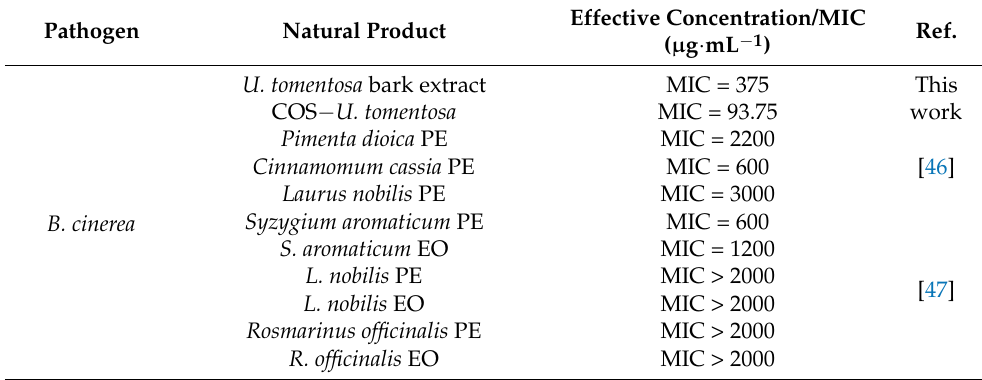
Table 6. Effective concentrations/MIC values reported in the literature for other bioactive natural products against the three pathogens under